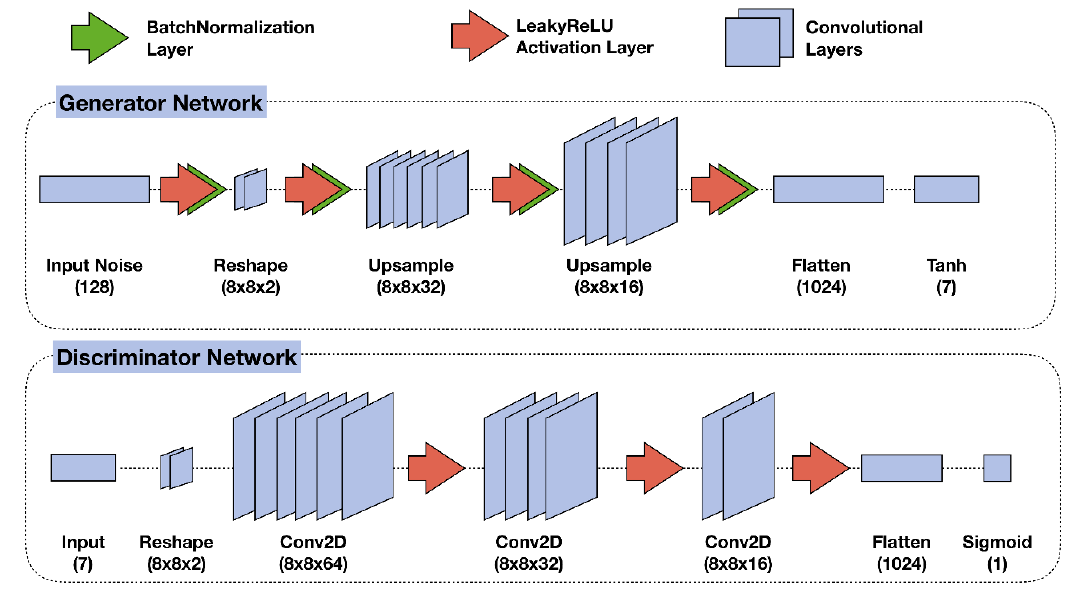
Figure 1 . Network architecture: generator (top), discriminator (bottom). The GAN is composed by connecting the output of the generator to the input of the